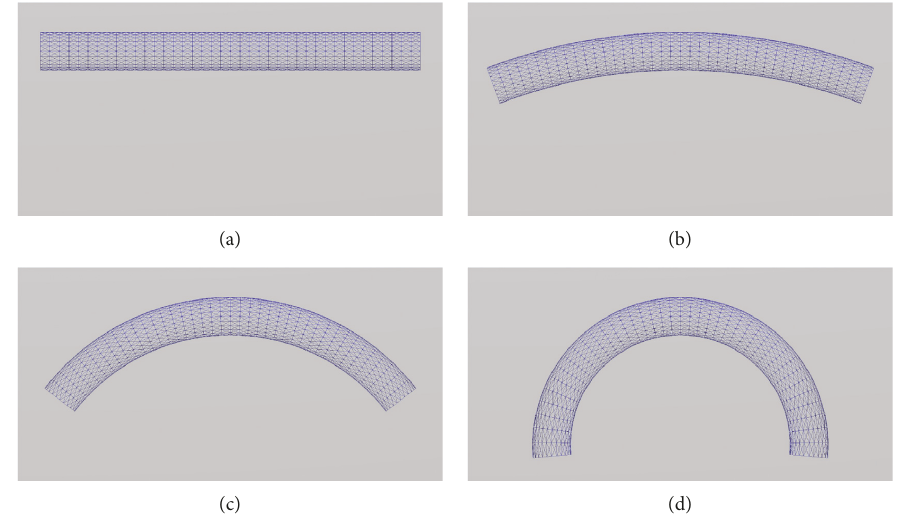
Figure 6: Curvature expression using the cylindrical mesh model ( R